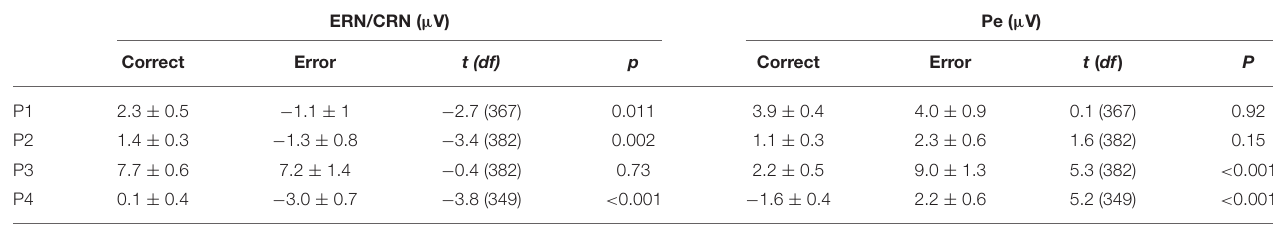
Depicted are means (SEM) and t-test results.